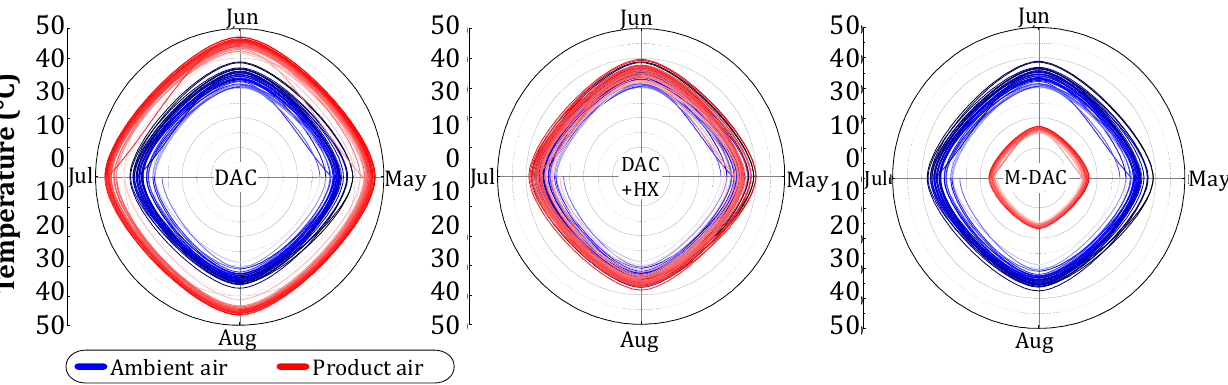
Figure 12. Performance profile of the proposed M-DAC system’s temperature gradient in summer months of Multan (Pakistan) for greenhouse air-conditioning application.